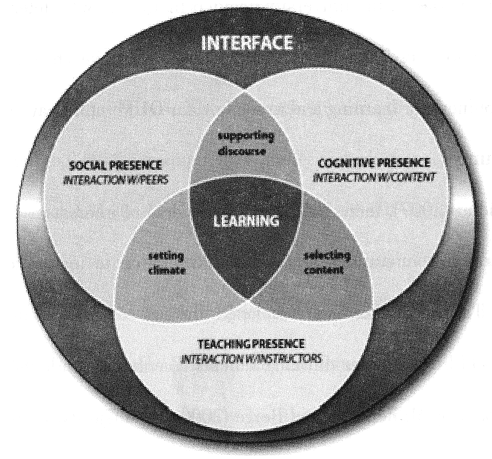
Figure 1. Community of Inquiry Model (Garrison, Anderson & Archer,